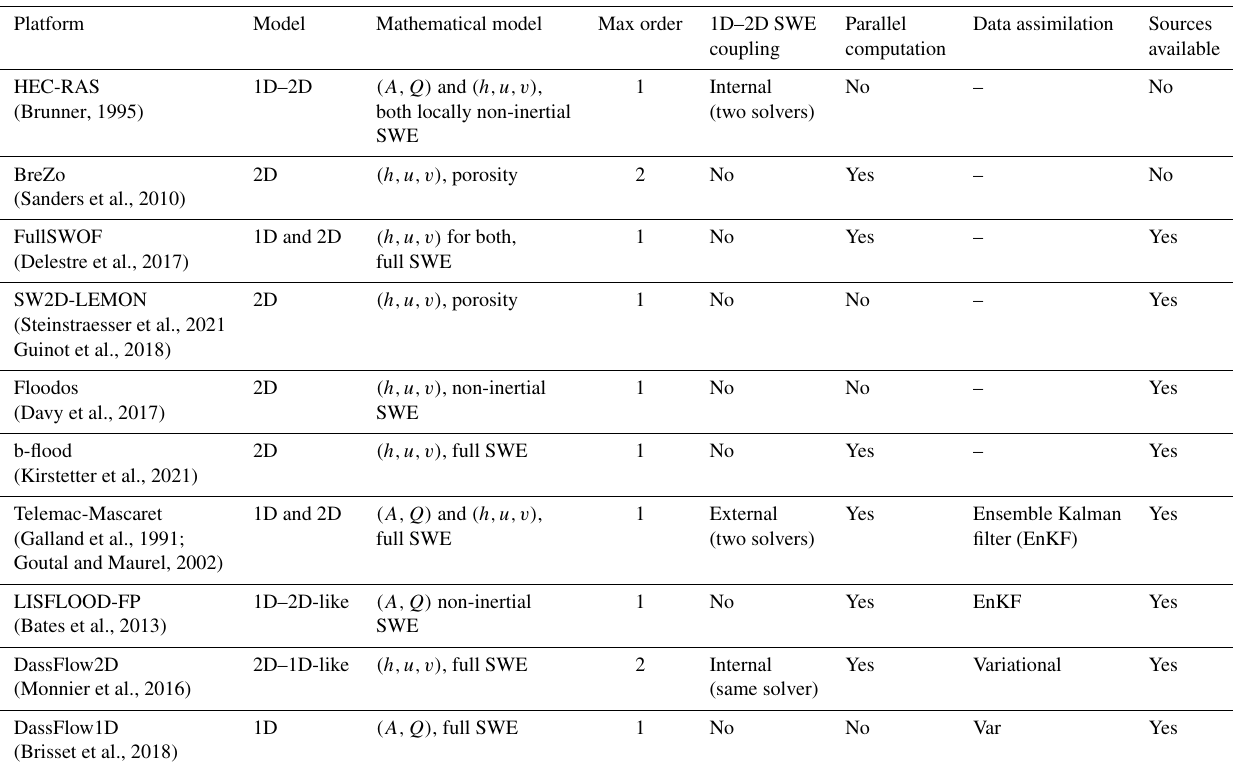
Table 1. Some established freeware hydraulic models. “SWE” stands for shallow-water equation. The equations resolved are either for- mulated in (A,Q) (flow section (cid:2) m 2 (cid:3) and at-a-section discharge (cid:2) m 3 s − 1 (cid:3) ) or in (h,u,v) (water depth [m] and 2D depth-integrated flow velocities (cid:2) ms − 1 (cid:3) ) . “Max order” refers to the maximum demonstrated scheme order. “Sources available” means that the source code is freely accessible, either through direct download or upon request.